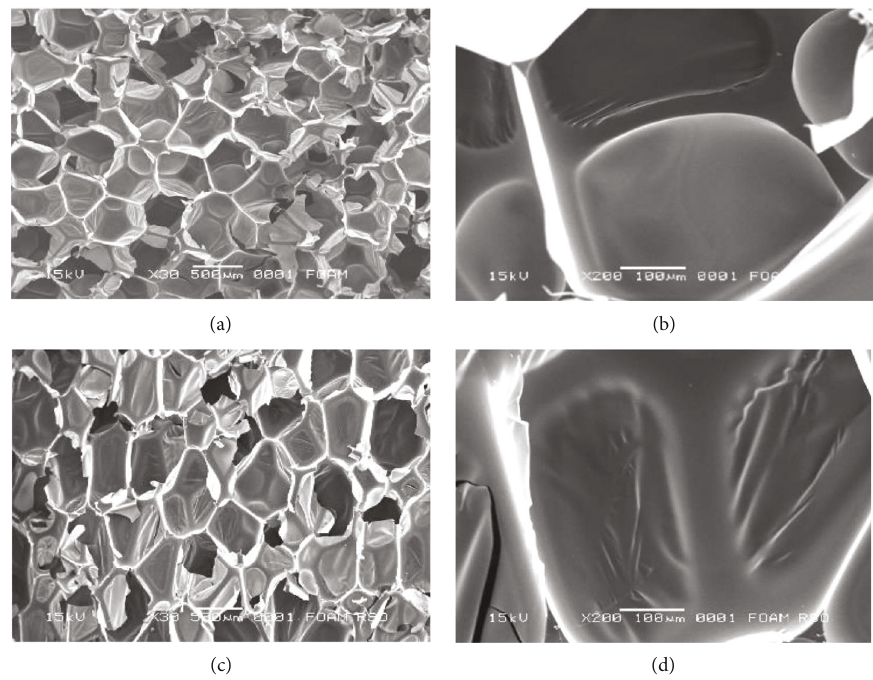
Figure 11: The SEM images of Foam-MH (a, b) and Foam-RSO (c, d).